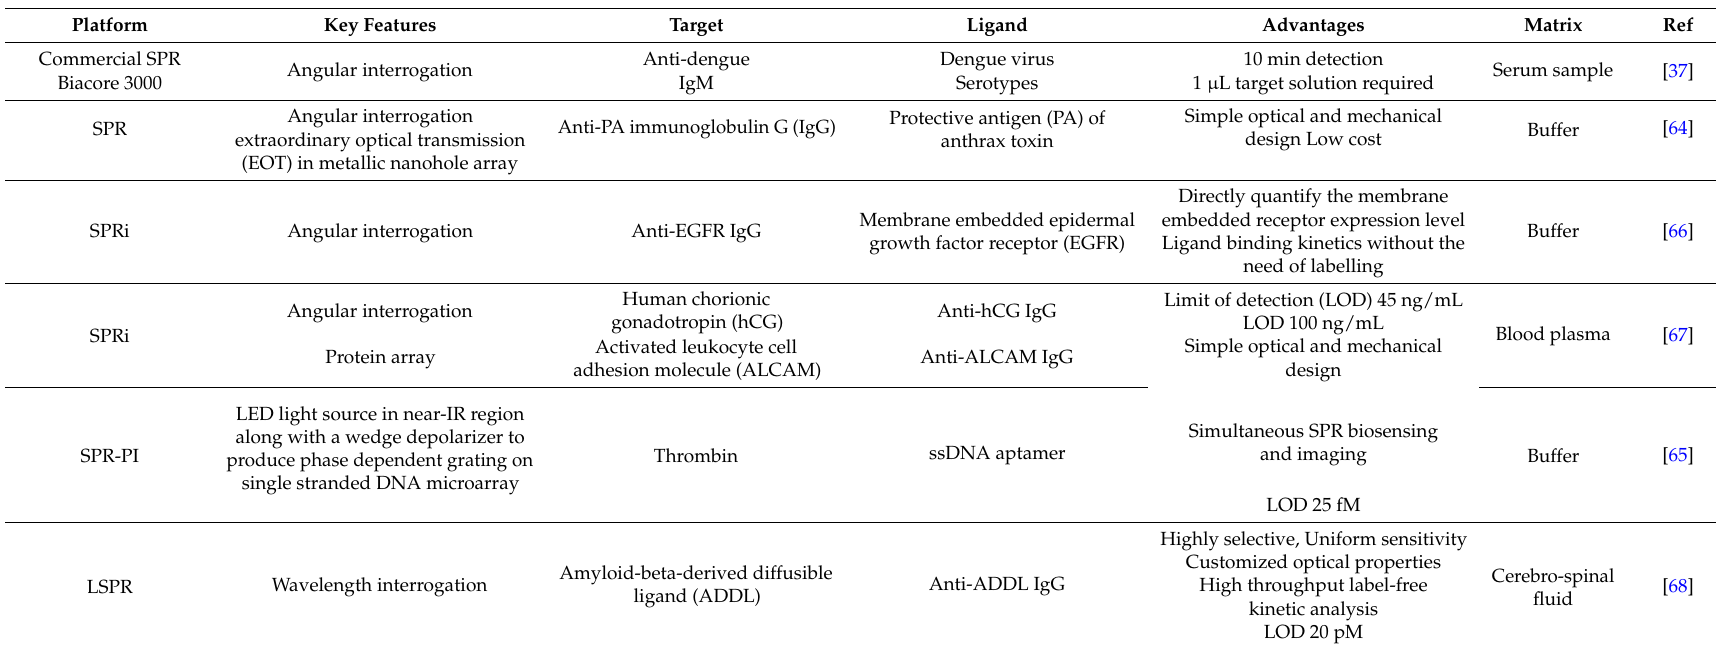
Table 1. Analysis of biomolecular events with SPR for clinical